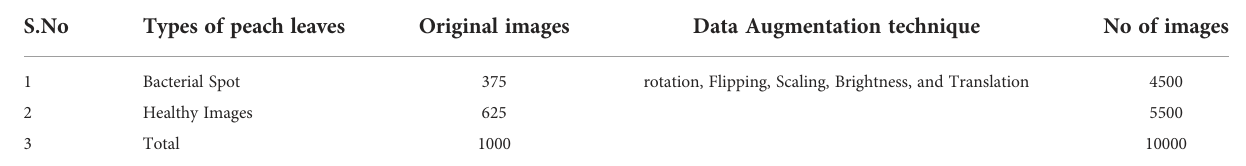
TABLE 1 The developed dataset details.